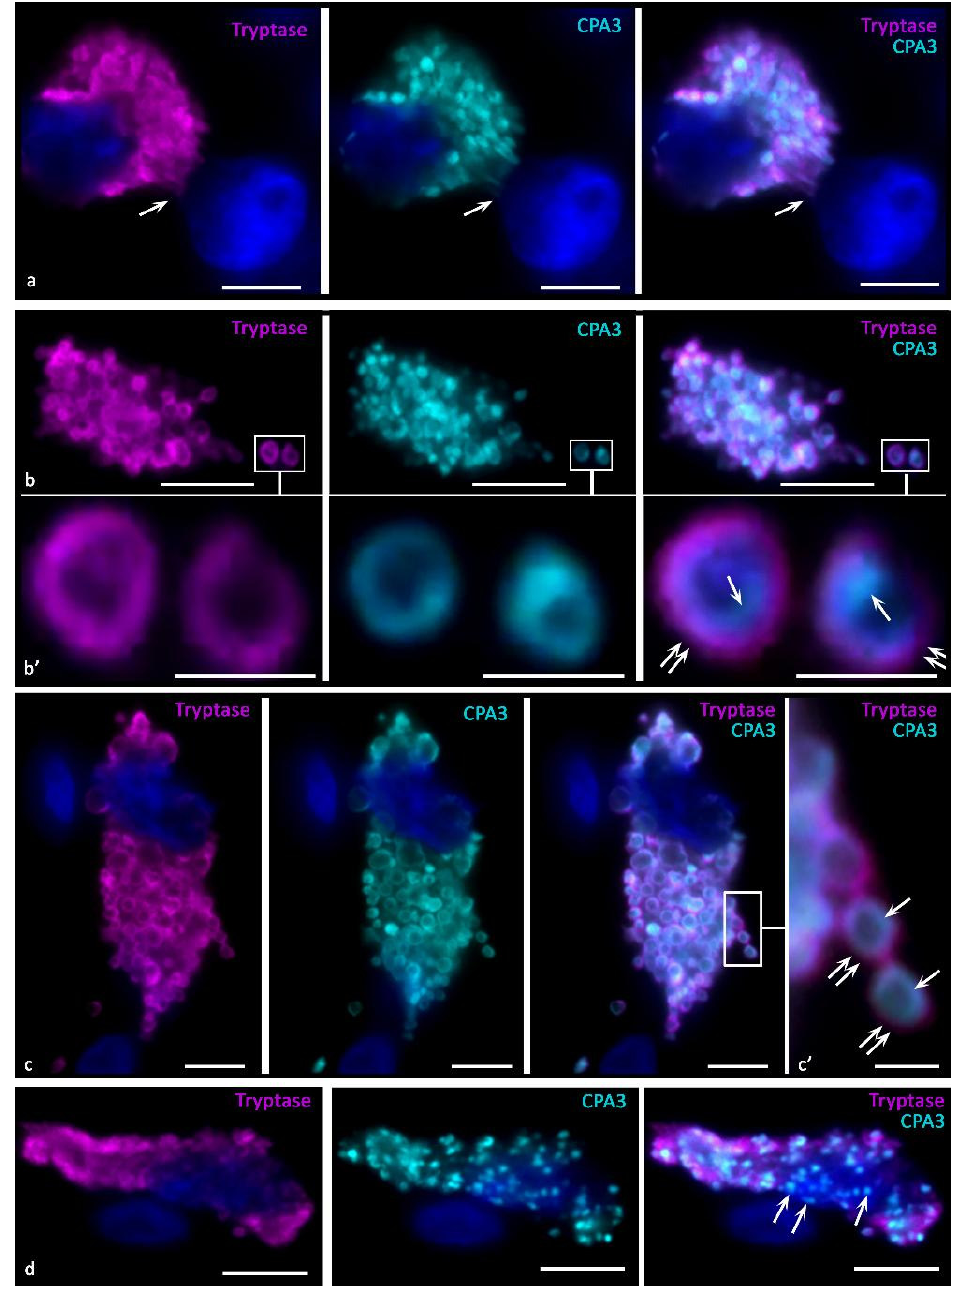
Figure 3. Intragranular localization of CPA3 and tryptase in mast cells of human skin in melanoma. Primary antibodies used: Rabbit polyclonal to CPA3 antibody (ab251696) (AbCam, Cambridge, UK), mouse monoclonal [AA1] to Mast Cell Tryptase antibody (ab2378) (AbCam). Secondary antibod- ies used: Goat anti-rabbit IgG Ab (#A-11034), Invitrogen, Darmstadt, Germany, label-Cy3; Goat anti-mouse IgG Ab (#A21236), Invitrogen, label-Alexa Fluor 647. ( a ) Tumor microenvironment. Colocalization of tryptase and CPA3 in mast cell granules, some of which are concentrated in the area of contact with the nucleus of a neighboring cell (indicated by an arrow). ( b , c ) General view of tumor associated mast cells. Tryptase and CPA3 are colocalized in the same granules, while in mature granules CPA3 is located medially from tryptase (indicated by an arrow), tryptase is located more peripherally (double arrow). ( b’ , c’ ) Enlarged areas of the image from the corresponding areas of photomicrographs, bounded by a frame. ( d ) CPA3 + mast cell secretory granules without tryptase (indicated by an arrow). Scale bar: 1 µ m ( b’ , c’ ), 5 µ m (the